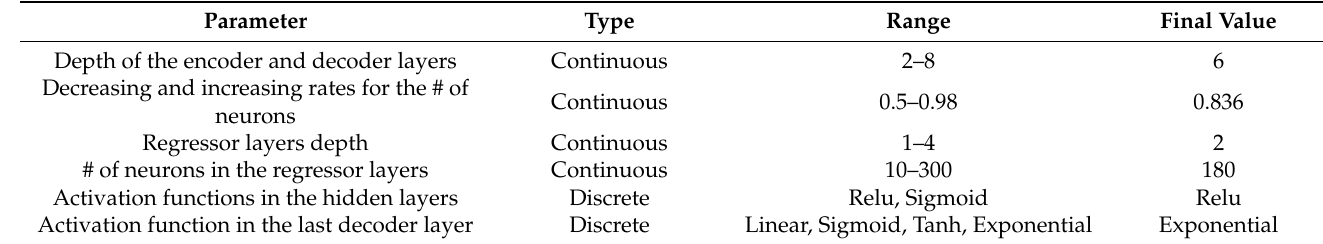
Table 2. Hyperparameter tuning results.